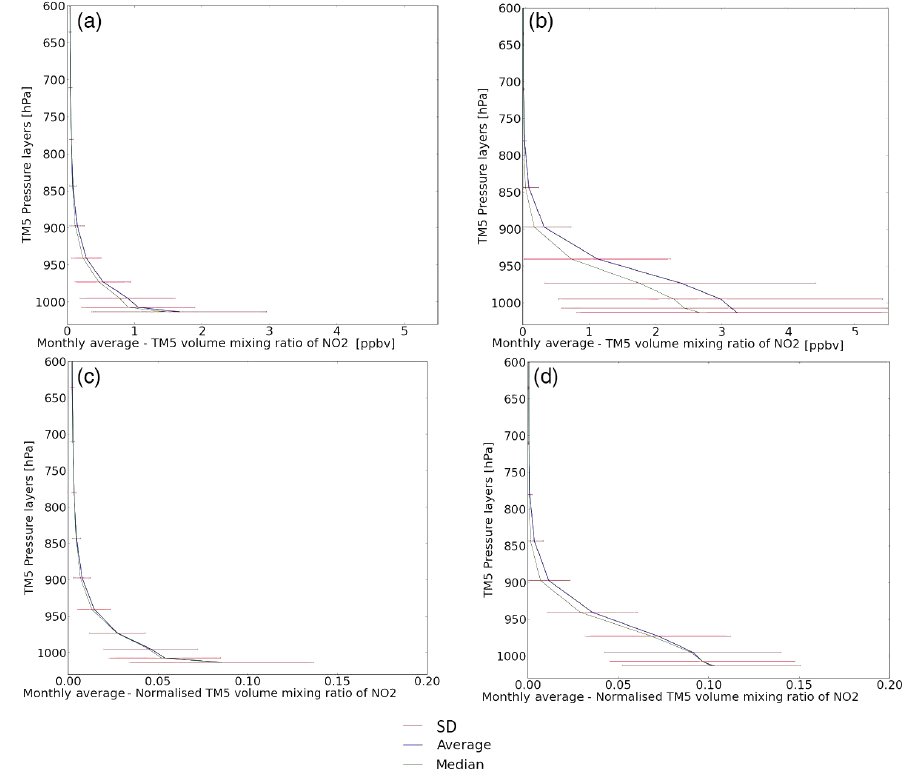
Figure 2. Monthly average NO 2 vertical profiles, zoomed in the troposphere, at 12:00 from TM5 simulations, 2006, East China (van Noije et al., 2014). (a) VMR NO 2 profile in July, (b) VMR NO 2 profile in January, (c) normalized NO 2 profile in July, (d) normalized NO 2 profile in January. Normalizations are done by dividing the VMR of each atmospheric layer to the integrated VMR profiles along the vertical atmospheric layers in the complete atmosphere, troposphere + stratosphere. SD here is the standard deviation.